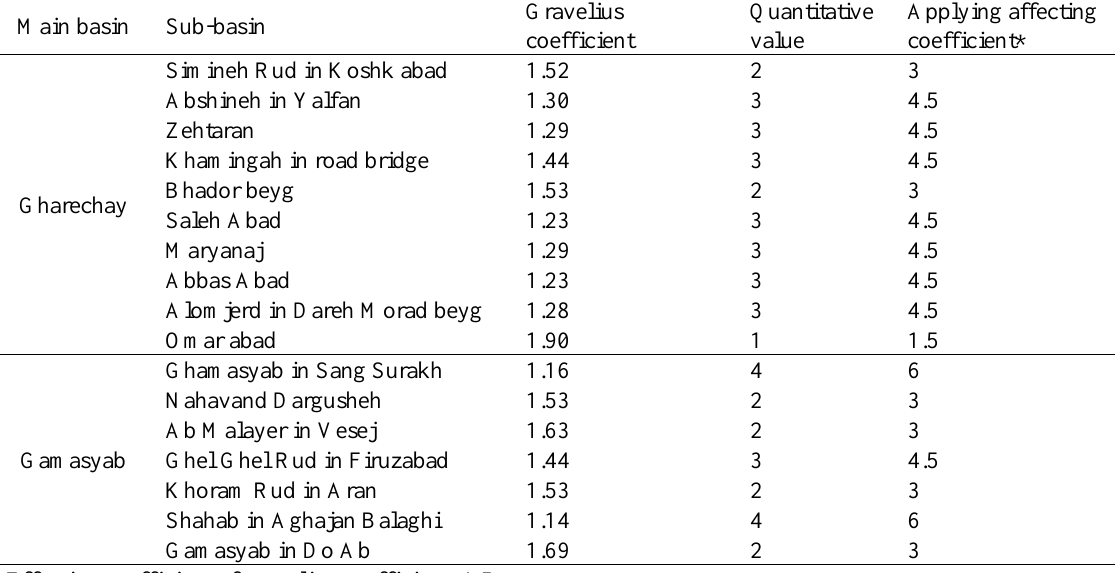
Gravelius coefficient